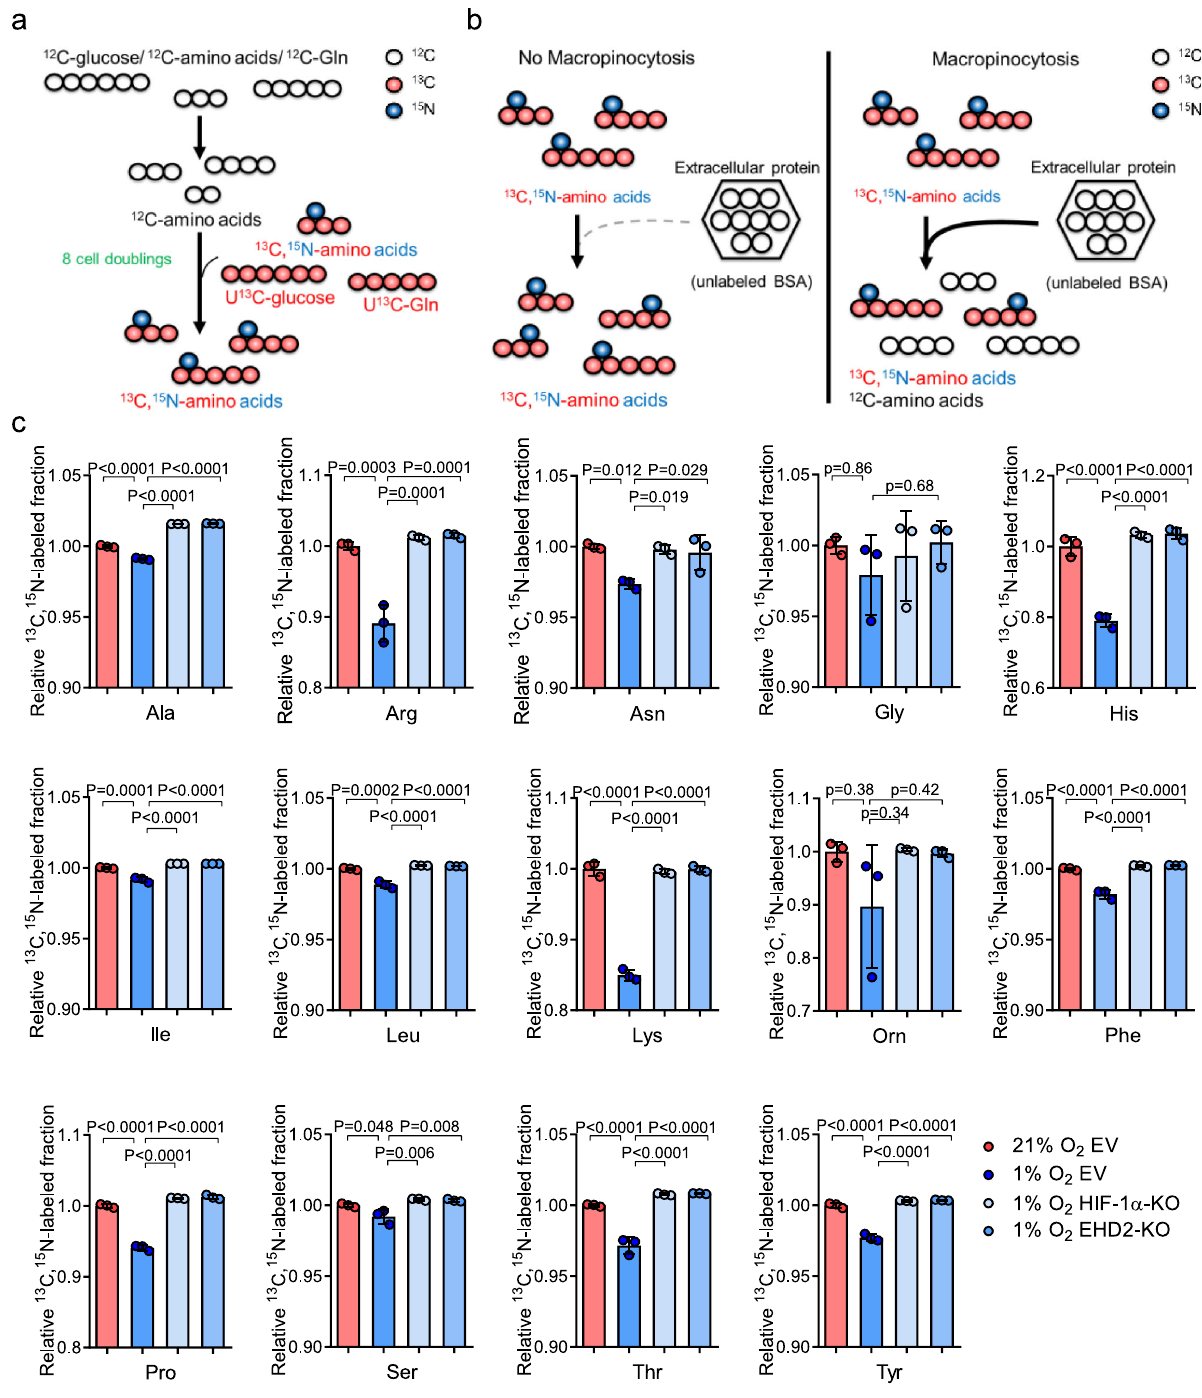
Fig. 5 Integration of scavenged extracellular protein into the intracellular amino acid pool through hypoxia-induced macropinocytosis. a , b The work fl ow of stable isotope exchange and isotope-tracing experiment. a HCC cells were cultured in 13 C, 15 N-DMEM containing U 13 C-glucose, U 13 C-glutamine (U 13 C-Gln), and 13 C, 15 N-amino acids for 8 cell doublings. The unlabeled amino acids were replaced with isotope-labeled amino acids. b Isotope-labeled HCC cells were cultured in 13 C, 15 N-DMEM with unlabeled BSA ( 12 C-BSA). Without macropinocytosis, intracellular amino acids should remain to be isotope-labeled. With macropinocytosis, scavenged 12 C-BSA becomes a source of amino acids and therefore decreases the ratio of isotope- labeled amino acids. c The 13 C, 15 N-labeled fraction of amino acids in MHCC97L-EV, -HIF-1 α -KO, and -EHD2-KO cells supplemented with 12 C-BSA and exposed to 21 and 1% O 2 . Values were normalized to 21% O 2 EV. Results were from 3 independent mass-spectrometry analysis. Error bars indicate mean ± SD. Two-way ANOVA with Bonferroni correction. Ala alanine, Arg arginine, Asn asparagine, Gly glycine, His histidine, Ile isoleukine, Leu leukine, Lys lysine, Orn ornithine, Phe phenylalanine, Pro proline, Ser serine, Thr threonine, Tyr tyrosine. Source data are provided as a Source Data fi le.